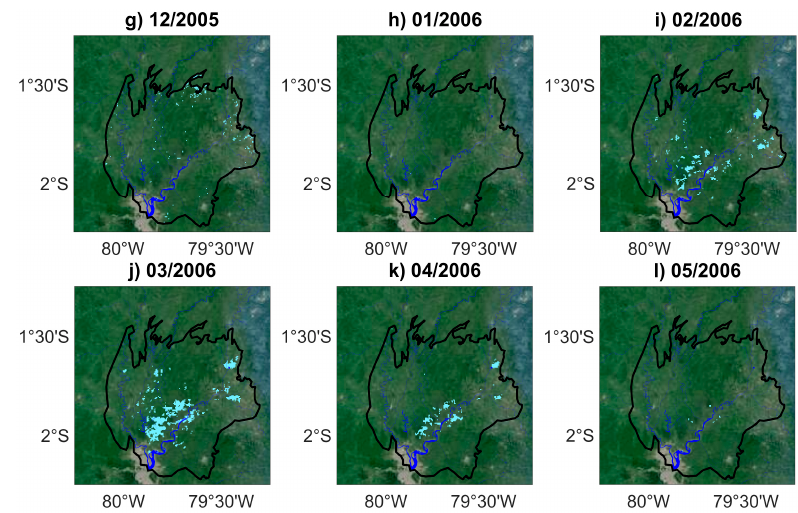
Figure 10. Monthly maps of inundation for normalized anomalies of backscattering coefficients lower than − 2.30 (light blue) in the Guayas floodplain (black line) during the wet seasons of 2005 and 2006 ( a – f ) from December 2004 to May 2005; and ( g – l ) from December 2005 to May 2006. Background image is from Google Maps. Permanent water bodies appear in blue.